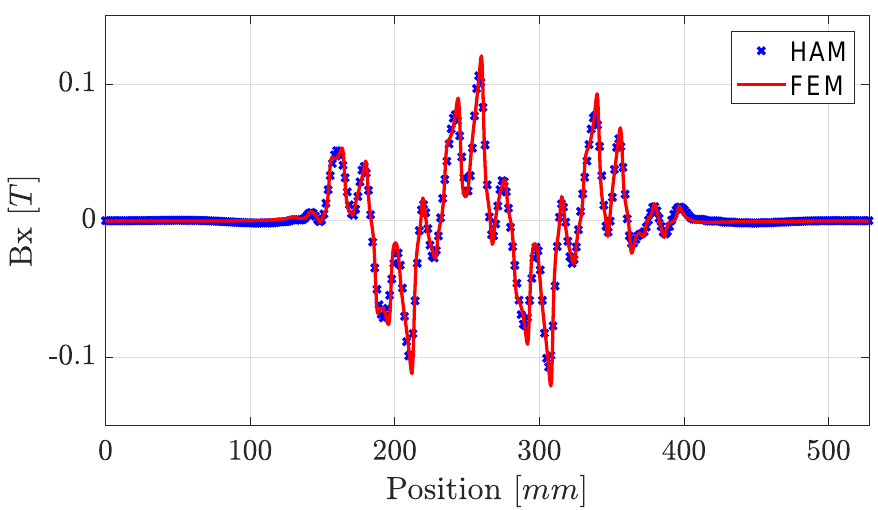
Figure 6. Magnetic flux density in normal direction in the middle of the air gap ( I p = 10 A, v = 0 m/s, f = 100 Hz).